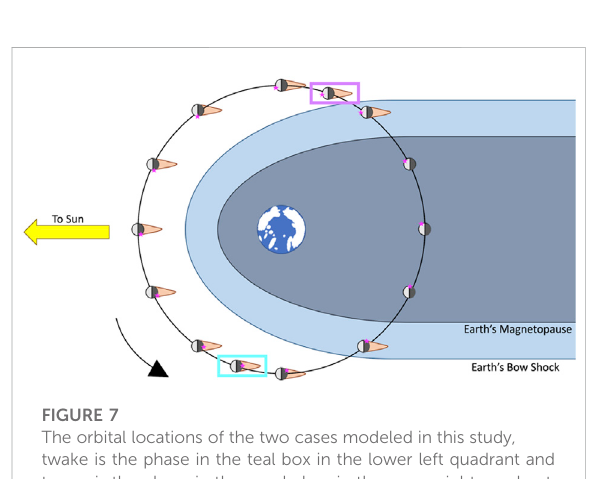
FIGURE 7 The orbital locations of the two cases modeled in this study, twake is the phase in the teal box in the lower left quadrant and tnoon is the phase in the purple box in the upper right quadrant. Both phases are outside of Earth ’ s magnetosphere so solar wind density and velocity are assumed to be nominal and are modulated by a constant that represents the local lunar solar wind